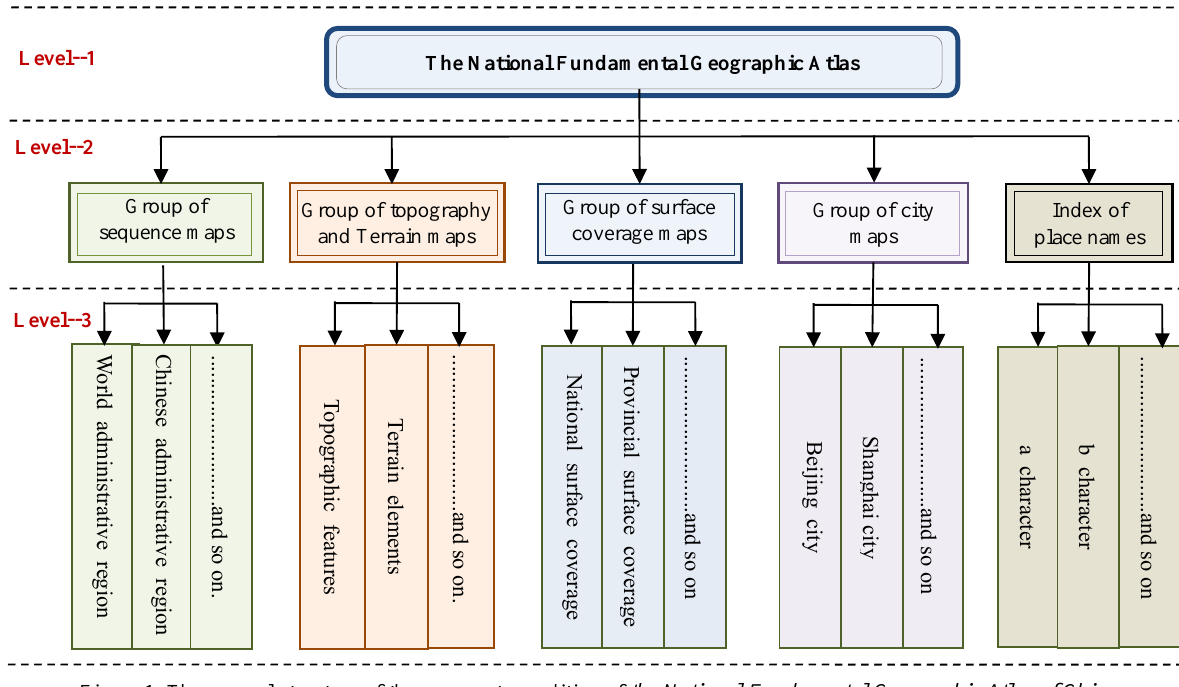
Figure 1. The general structure of the new century edition of the National Fundamental Geographic Atlas of